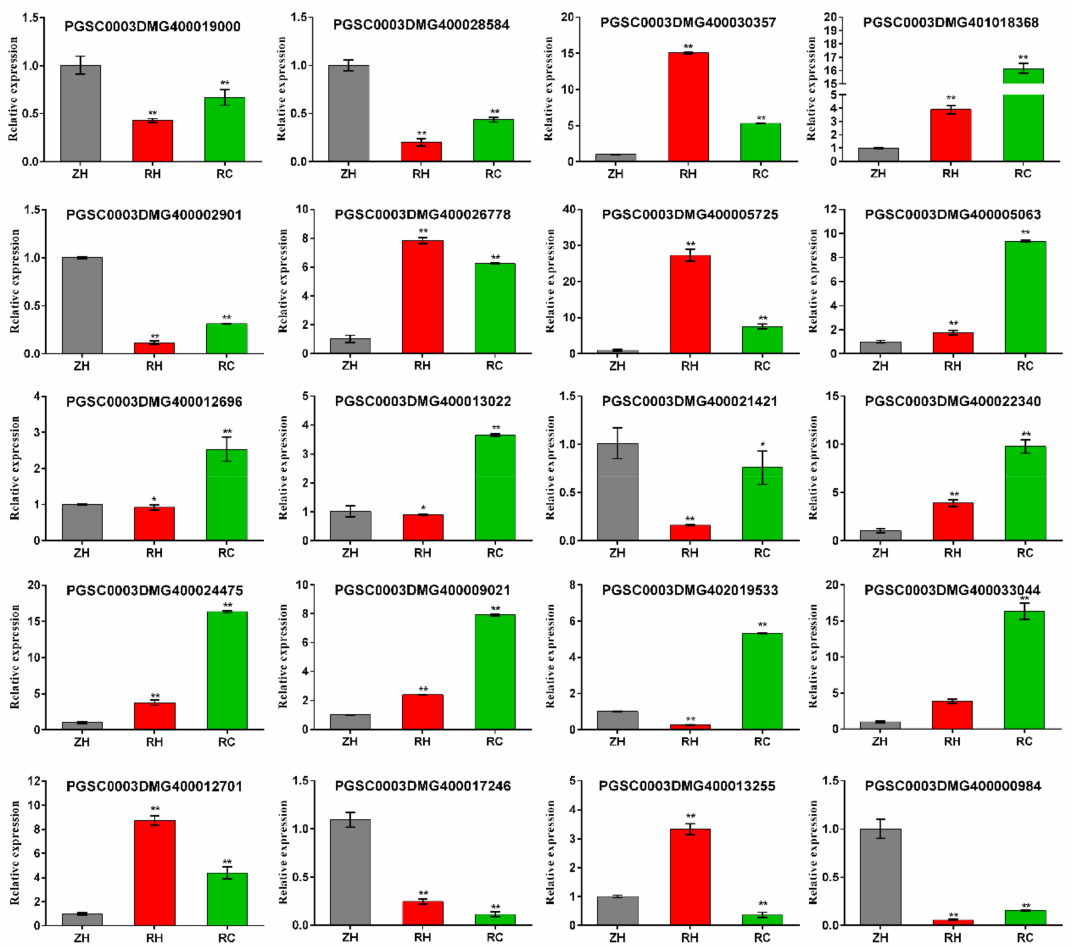
Figure 11. Expression analysis of DEGs under weak light and exogenous Ca 2 + by qRT-PCR. The experiment included three biological replicates and used SPSS analysis. We chose 20 DEGs including 2 (light), 3 (far-red light), 2 (shade avoidance), 5 (calcium regulation), 3 (GA), 2 (Eth), 1 (BR) and 2 (IAA) (Table S2). Values represent the mean ± S.E. ( n = 3). Letters indicate significant di ff erences at p < 0.05 according to Duncan’s multiple range